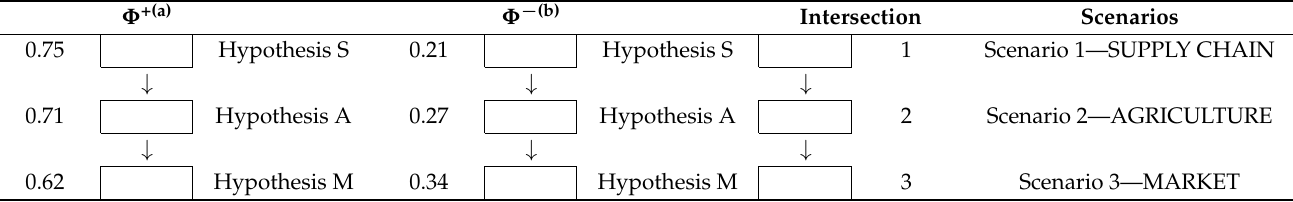
Table 5. Alternative scenarios and their classification obtained by multicriteria